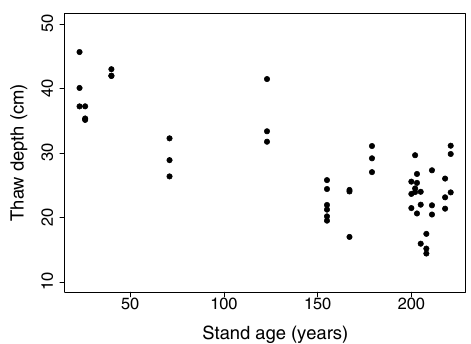
Figure 4. Relationship between thaw depth and stand age. Each point represents the average thaw depth measurement taken along a transect (three transects per site) and the stand age of the entire site. Thaw depths were measured in July/August of 2012 and